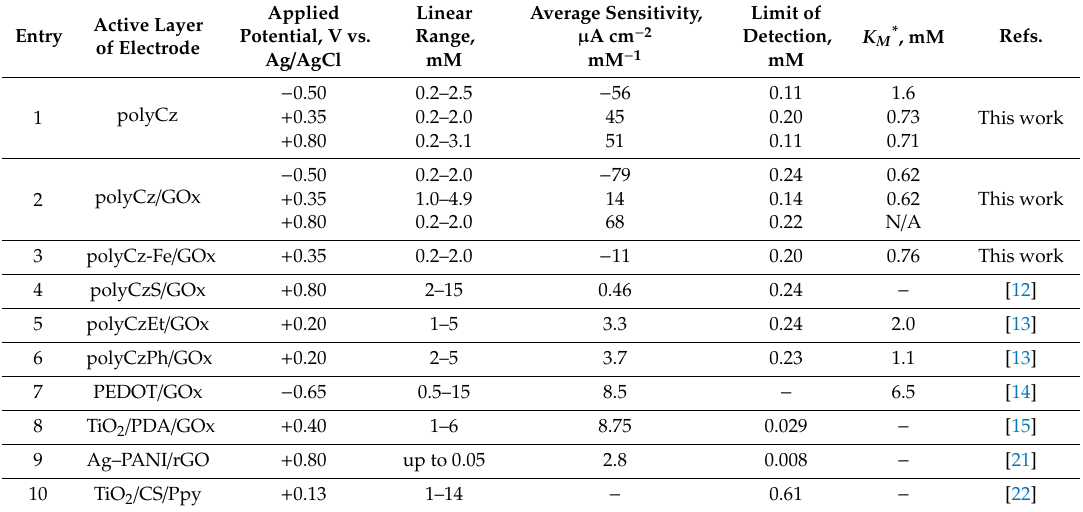
Table 1. Comparison of our electrochemical glucose biosensors with the data available in the literature.